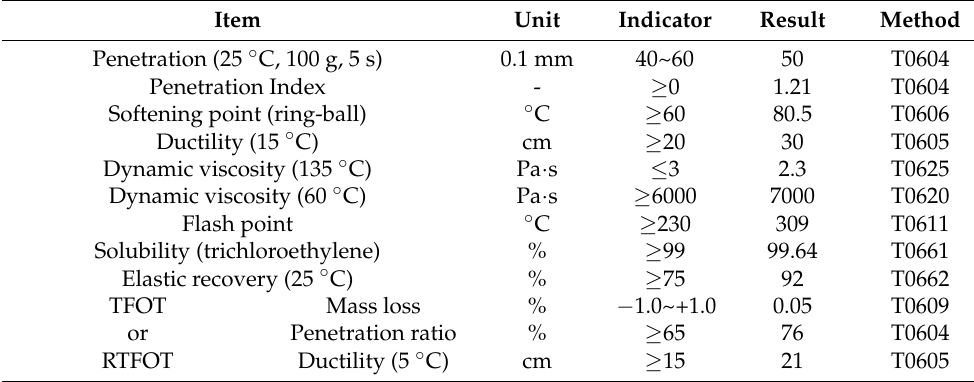
Table 3. Main indexes of SBS (I-D)-modified